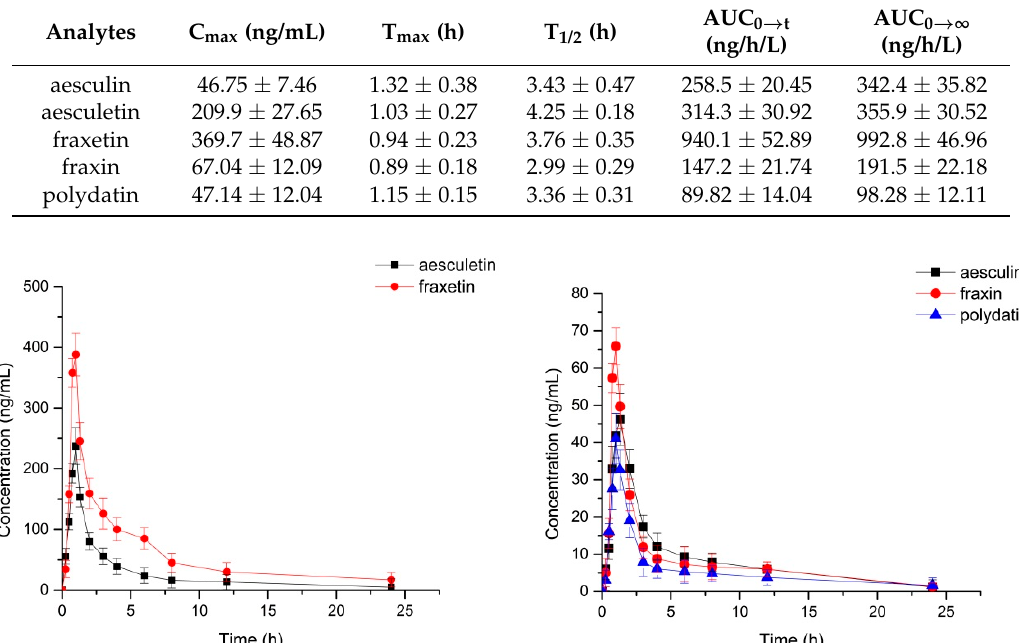
Table 6. Pharmocokinetic parameters of five analytes in beagle dog plasma after oral administration of the extract of Ledum palustre L.